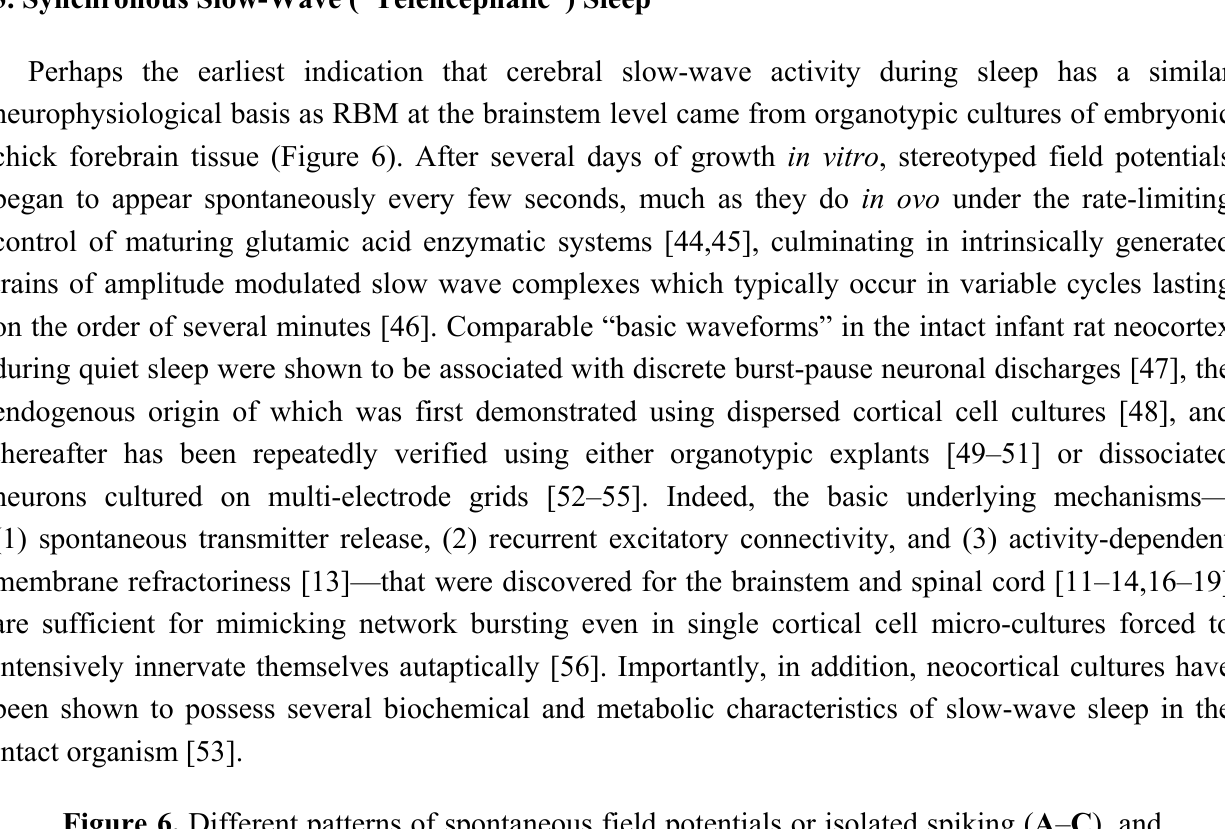
Figure 6. Different patterns of spontaneous field potentials or isolated spiking ( A – C ), and all-or-none evoked responses ( D – F ) in organotypic chick embryo cerebral hemisphere explants: oscillographically recorded in 1968 at the Albert Einstein College of Medicine, New York, NY,